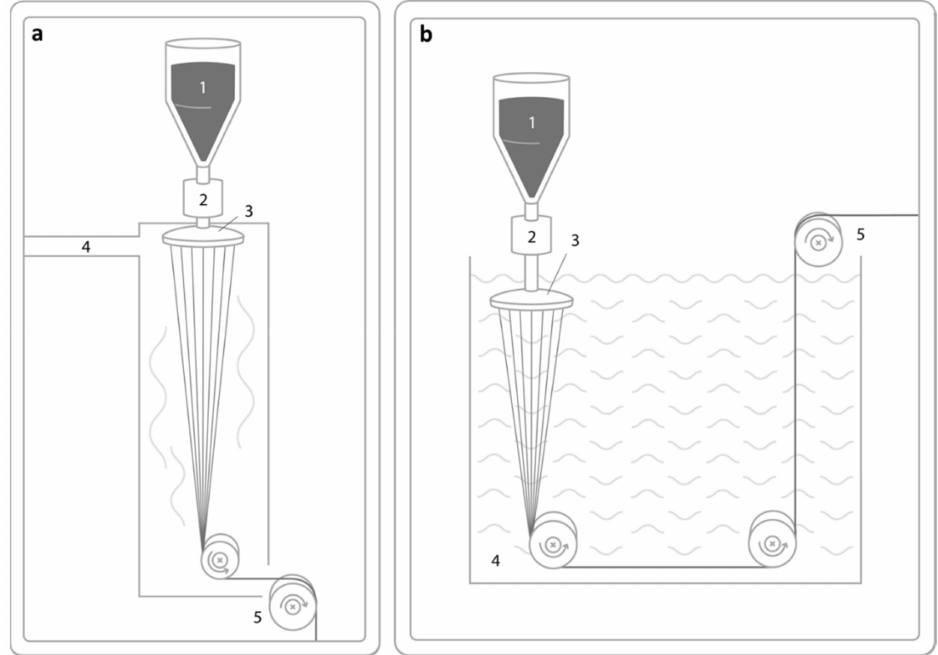
Figure 4. Schematic drawing of dry spinning ( a ) with the polymer solution (1), the pump (2), spinneret (3,) heated chamber (4), and subsequent winding or further processing (5), and the wet spinning process ( b ) with the polymer solution (1), pump (2), spinneret (3), coagulation bath (4) and subsequent winding or further processing